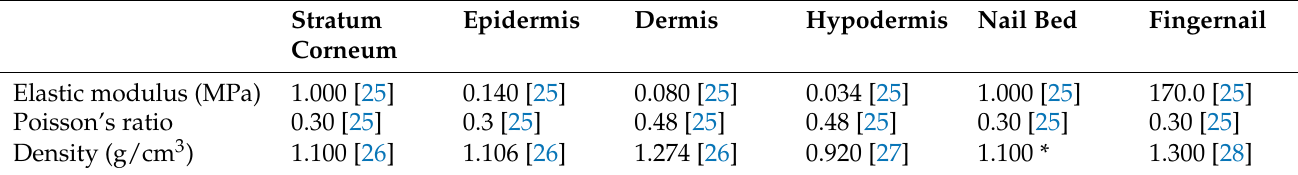
Table 2. The values of elastic modulus, Poisson’s ratio, and density for six fingertip tissue layers. The selected values are given along with the references from which they were